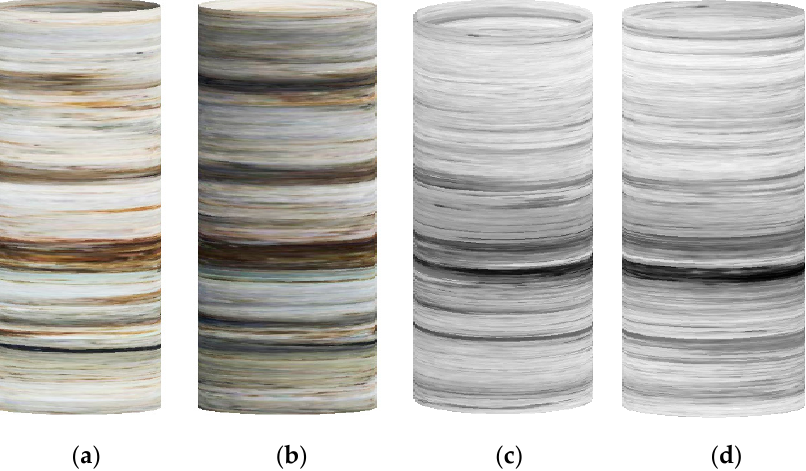
Figure 17. Before and after borehole wall fusion. ( a ) Pre-fusion image (N-S azimuth), ( b ) pre-fusion image (S-N azimuth), ( c ) post-fusion image (N-S azimuth), ( d ) post-fusion image (S-N azimuth).